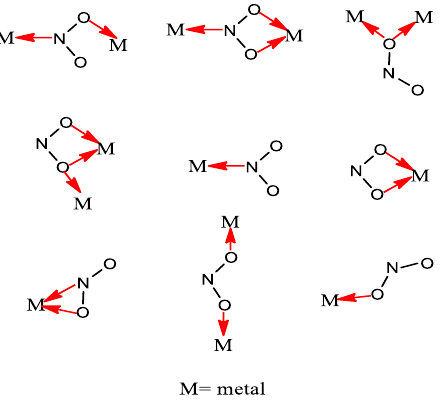
Figure 1. Different coordination modes of NO 2 group.